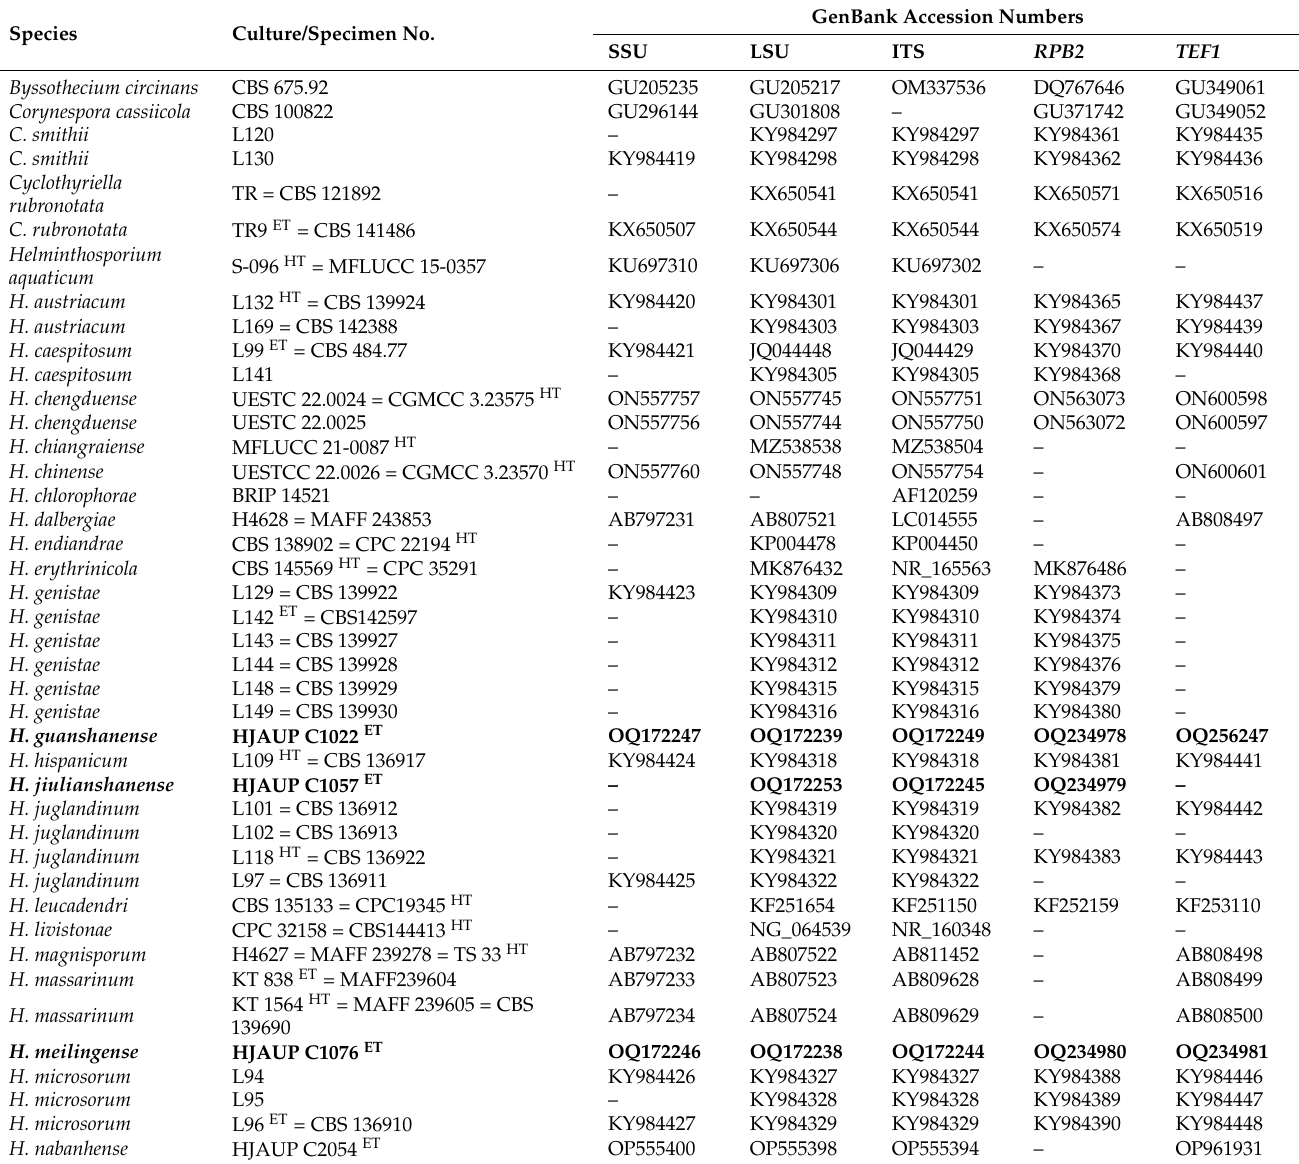
Table 1. Species and GenBank accession numbers of DNA sequences used in this study. New sequences are in